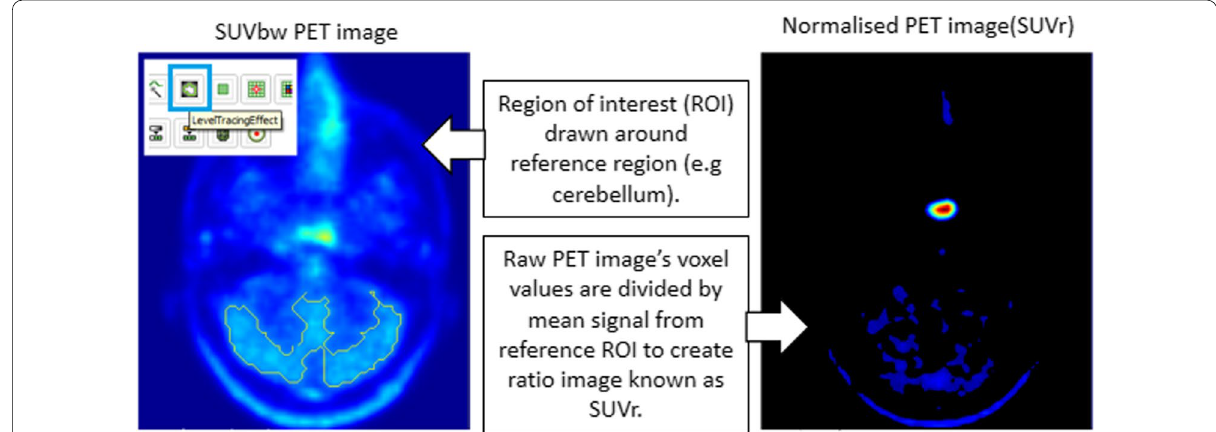
Fig. 2 Normalization of PET images. ROI drawn around the reference region (cerebellum shown here) on one slice of the PET image. The PET images are divided by the mean signal from the reference ROI to create a ratio image known as standardized uptake value ratios (SUVrs)